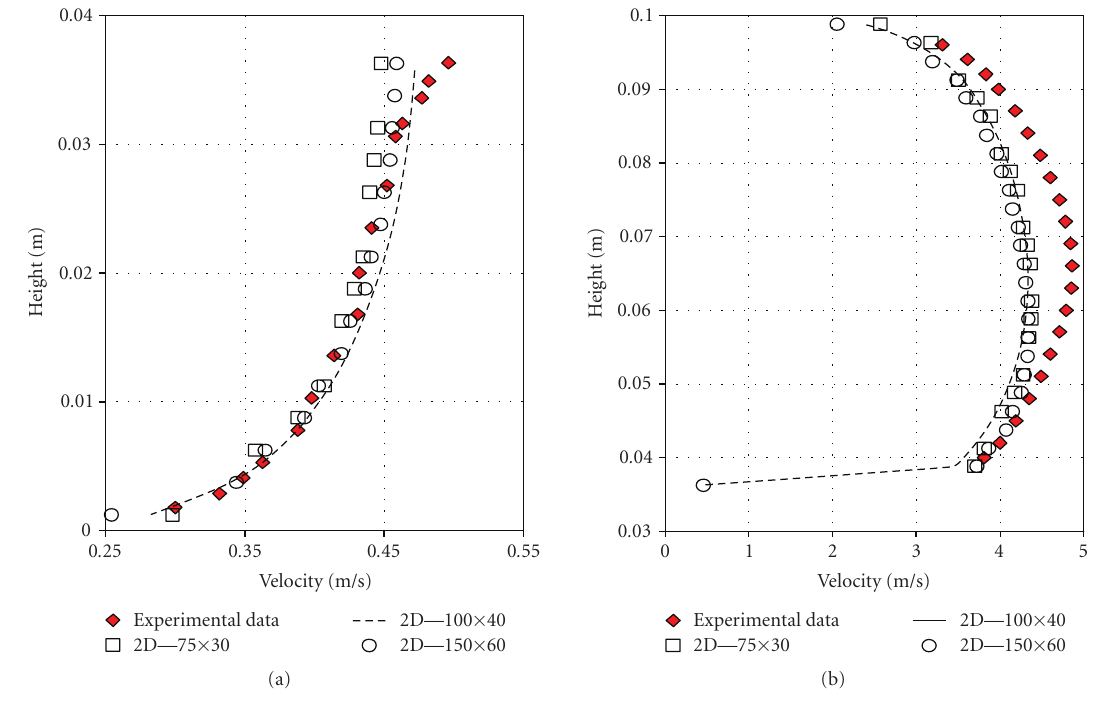
Figure 7: Velocity profiles: (a) water; (b)